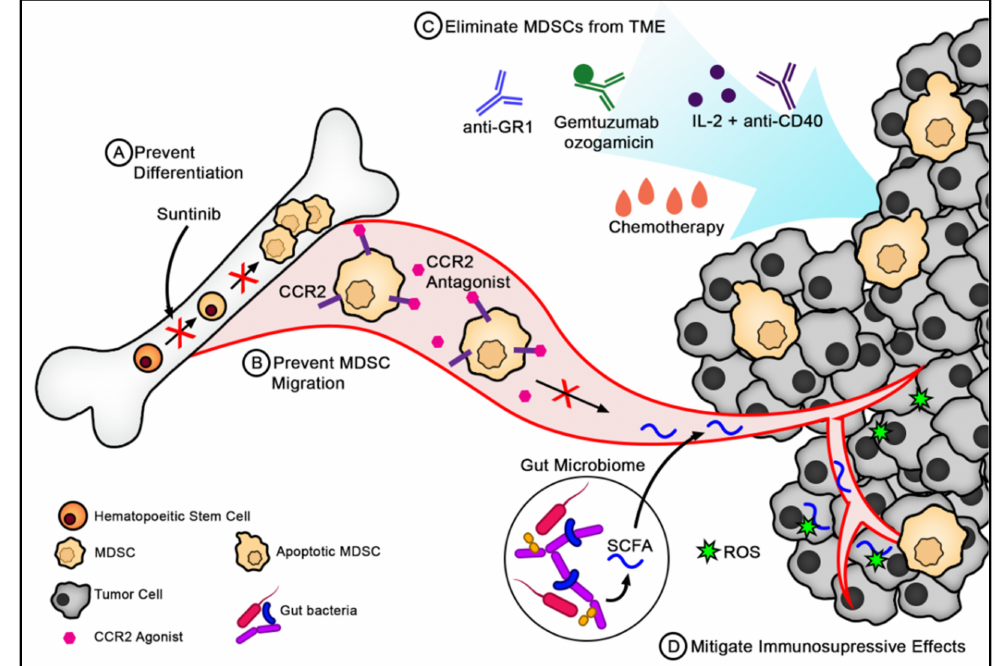
Figure 2. Strategies for targeting MDSCs in cancer. ( A ) Preventing differentiation of hematopoietic stem cells into MDSCs. Sunitinib is a tyrosine kinase inhibitor that inhibits VEGF and STAT3 activity, both of which are crucial in the differentiation and expansion of MDSCs. ( B ) Preventing MDCSs from migrating to the tumor. Chemokines such as CCL2 are critical for the recruitment of MDSCs to the TME. As CCL2 binds CCR2 on the surface of MDSCs, specific CCR2 antagonists can hinder the migration to MDSCs toward the TME. ( C ) Eliminating MDSCs from the tumor by using a variety of immunotherapies and chemotherapy. MDSCs express surface molecules such as Gr1, CD33, and CD40, which provide a target for MDSC depleting antibodies such as anti-Gr1, gemtuzumab ozogamicin (GO), and anti-CD40, respectively. While chemotherapies such as 5-fluorouracil do not specifically target MDSCs, they can effectively eliminate MDSCs through apoptosis. ( D ) Mitigating the immunosuppressive effects of MDSCs at the tumor site. The gut microbiota is capable of producing short-chain fatty acids (SCFAs), which can limit the toxicity associated with ROS produced by